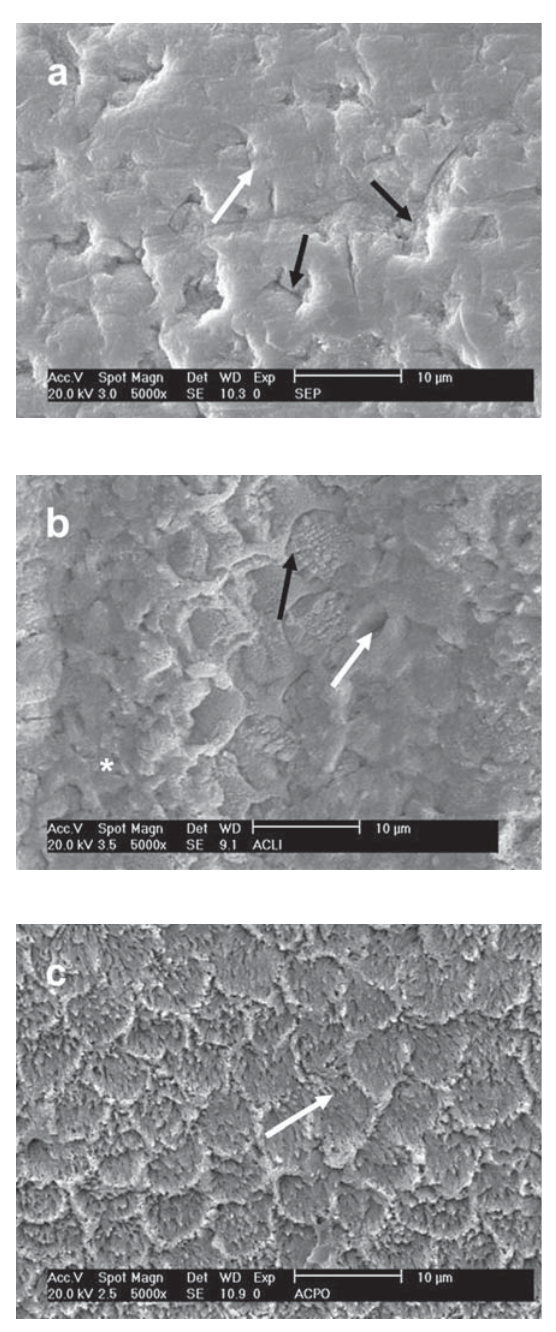
FIGURE 3- Effects of 35% phosphoric acid etching on the different enamel-prepared surfaces. a – Prophylaxis: Areas of specific enamel etching pattern (white arrow – type 1 pattern; black arrow – type 2 pattern); b – SiC paper: The same morphological findings of Figure a, emphasizing the areas with a non-uniform etching pattern (white asterisk); c – Diamond bur: Type I etching pattern (white arrow) is predominantly seen